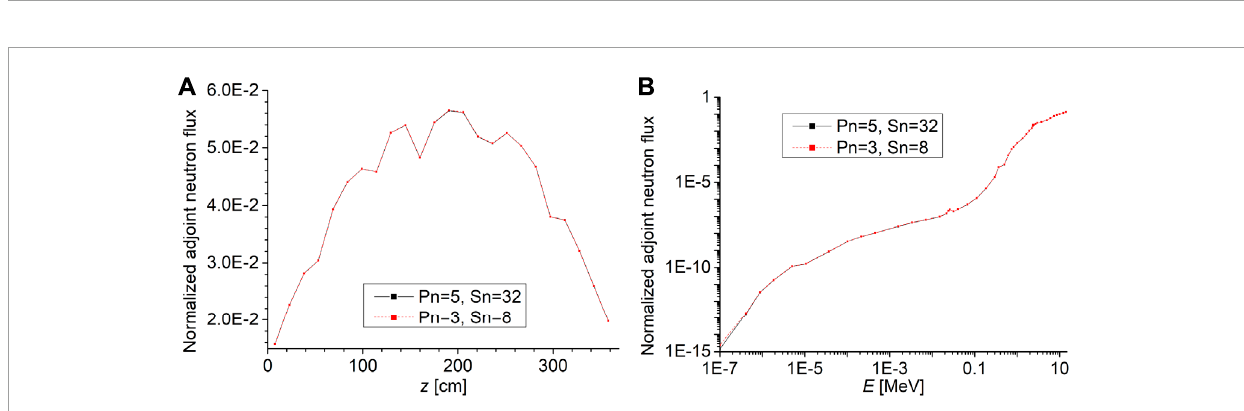
FIGURE 13 Adjoint neutron flux distribution in fuel assembly K-11, inside fuel pin at location (16,16). (A) Axial adjoint neutron flux profile. (B) Energy dependance of adjoint neutron flux.